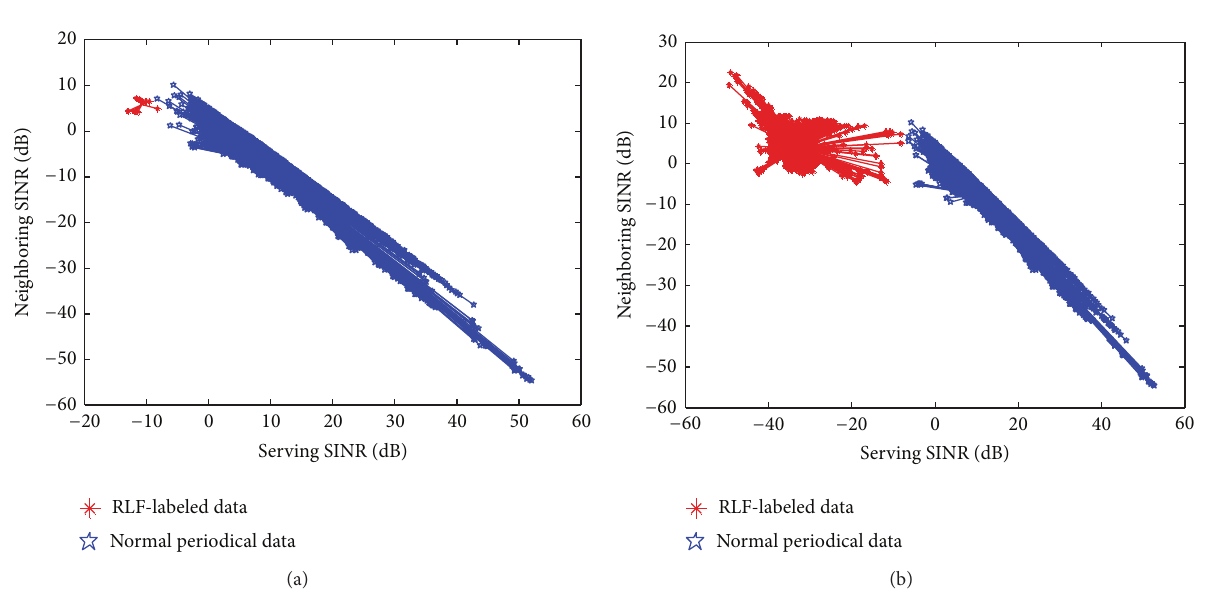
Figure 3: Classification results with KNN classifier in different simulations: (a) results in the reference simulation and (b) results in the problematic